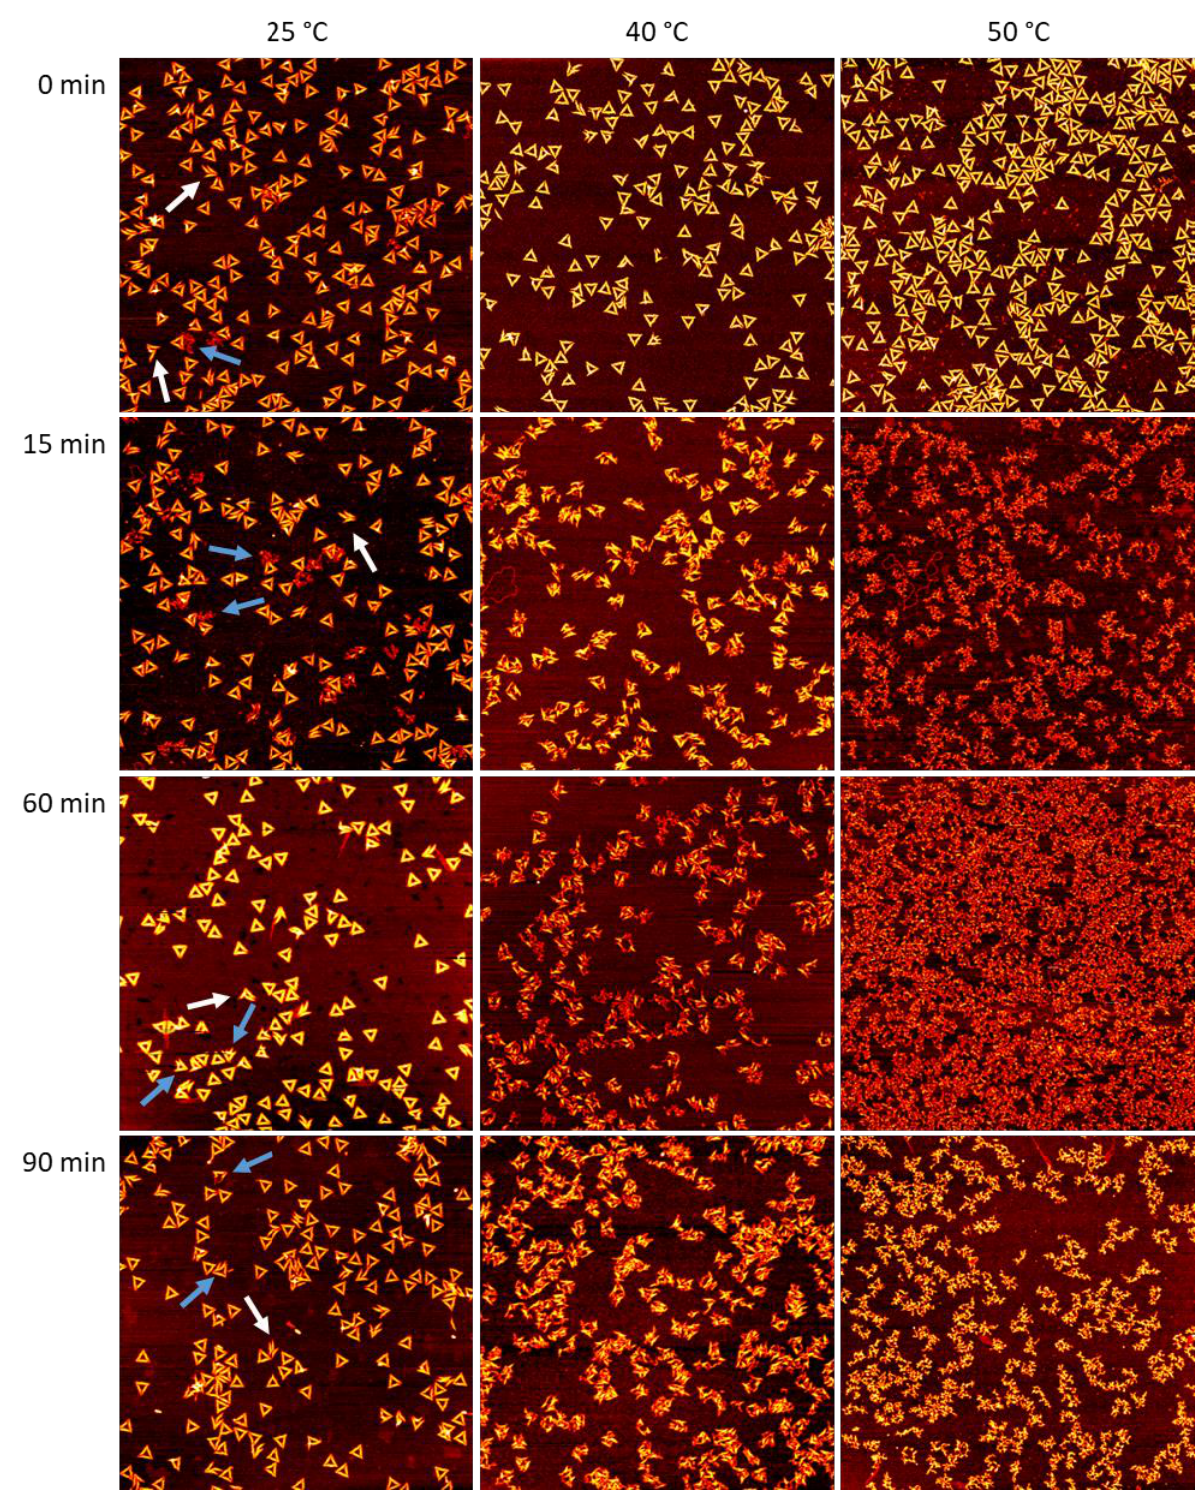
Figure 5. AFM images of DNA origami triangles after incubation in 2 M GdmSCN at different times and temperatures. Images have a size and height scale of 3 × 3 µm 2 and 2 nm, respectively. The white arrows indicate collapsed triangles with ruptured vertices, while blue arrows indicate triangles with damaged trapezoids or dangling scaffold. For additional AFM images, see Figures